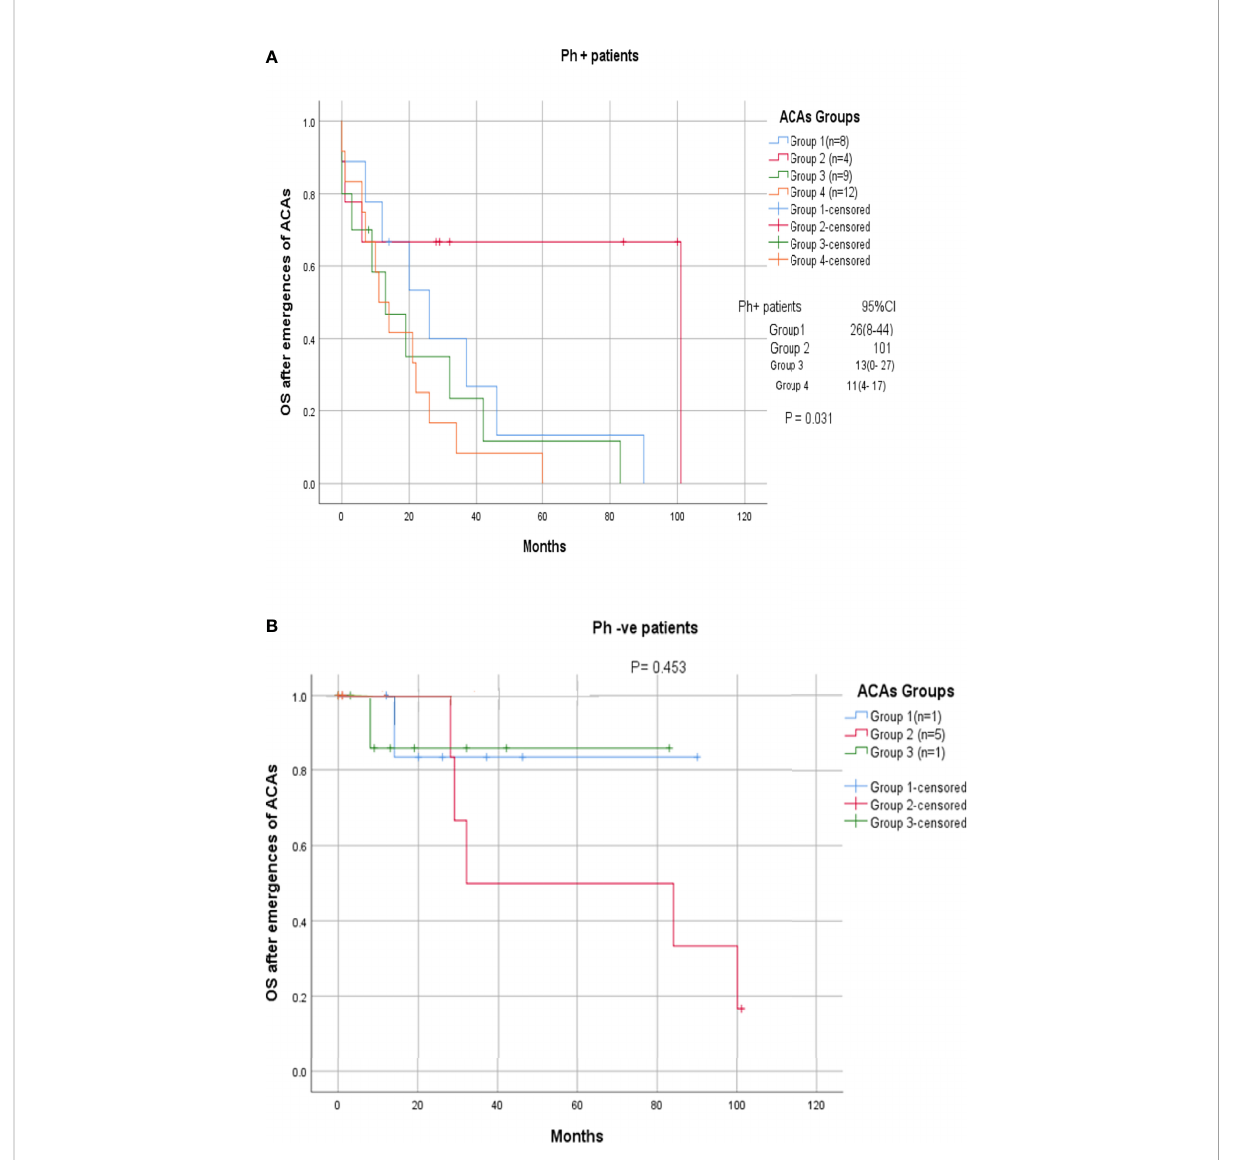
FIGURE 2 (A, B) CML patients with different groups of ACAs (group 1, group 2, group 3, and group 4) and their overall survival